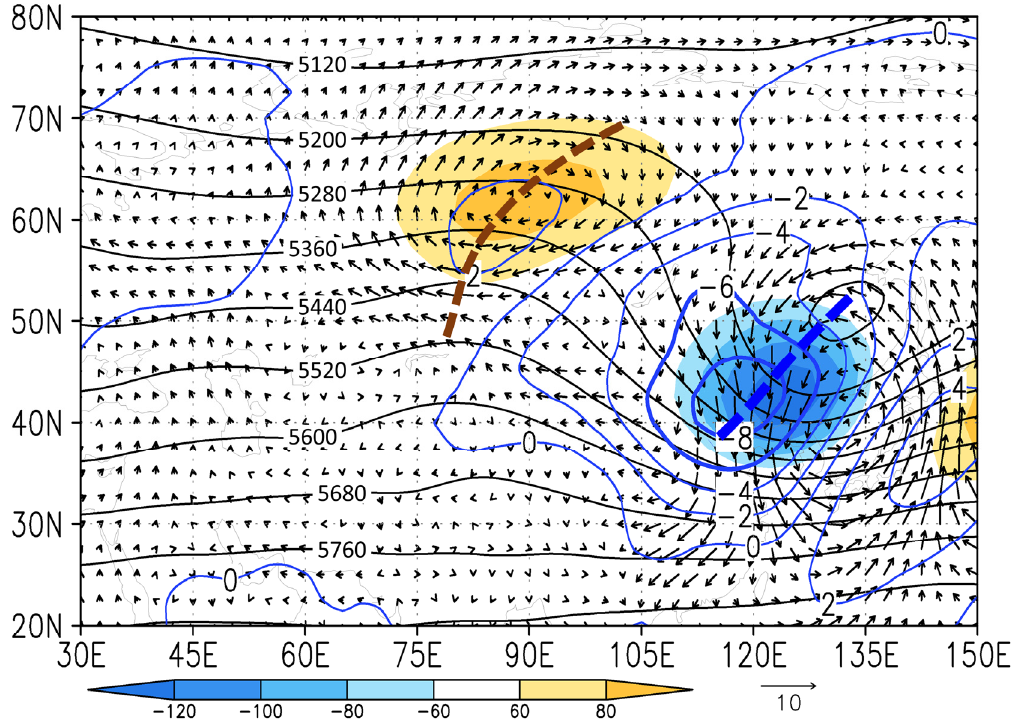
Figure 5. Composites of the 500 hPa geopotential height (GPH) (black contours, unit: gpm) and its anomalies (shadings, unit: gpm), 850 hPa air temperature anomalies (blue contours, unit: ◦ C) and horizontal wind anomalies (arrows, unit: m / s) on the occurring days of all ECSs in the domain. The thick brown and blue dashed lines mean the ridge and trough.